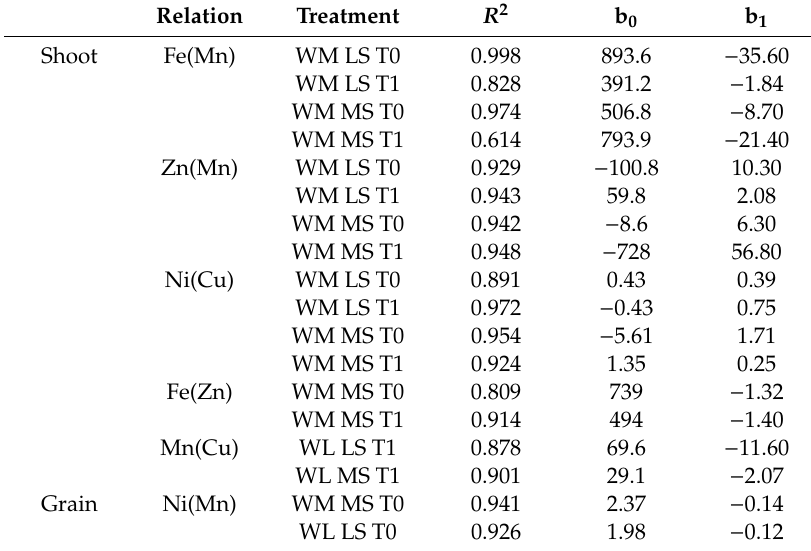
Table 3. Coe ffi cients in regression equation y = b 0 + b 1 x and coe ffi cients of determination (for regression coe ffi cients statistically di ff erent from zero, α =